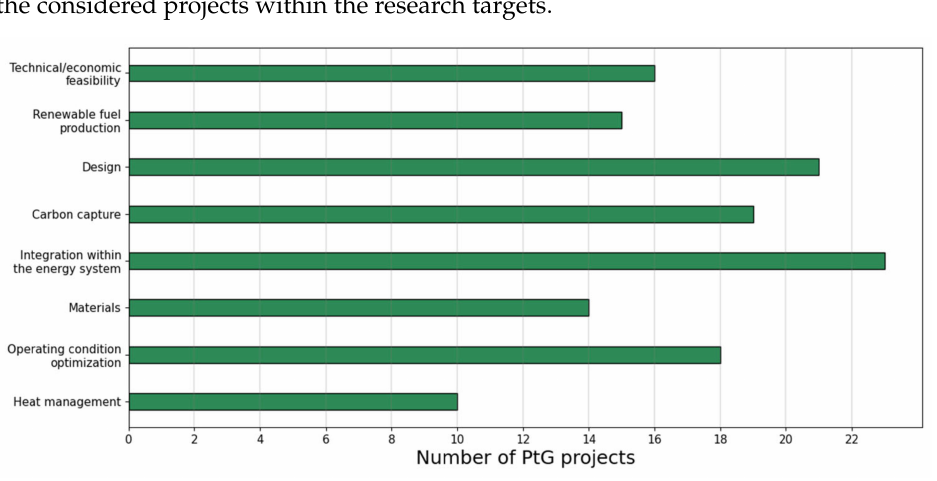
Figure 8. Number power-to-gas projects per research